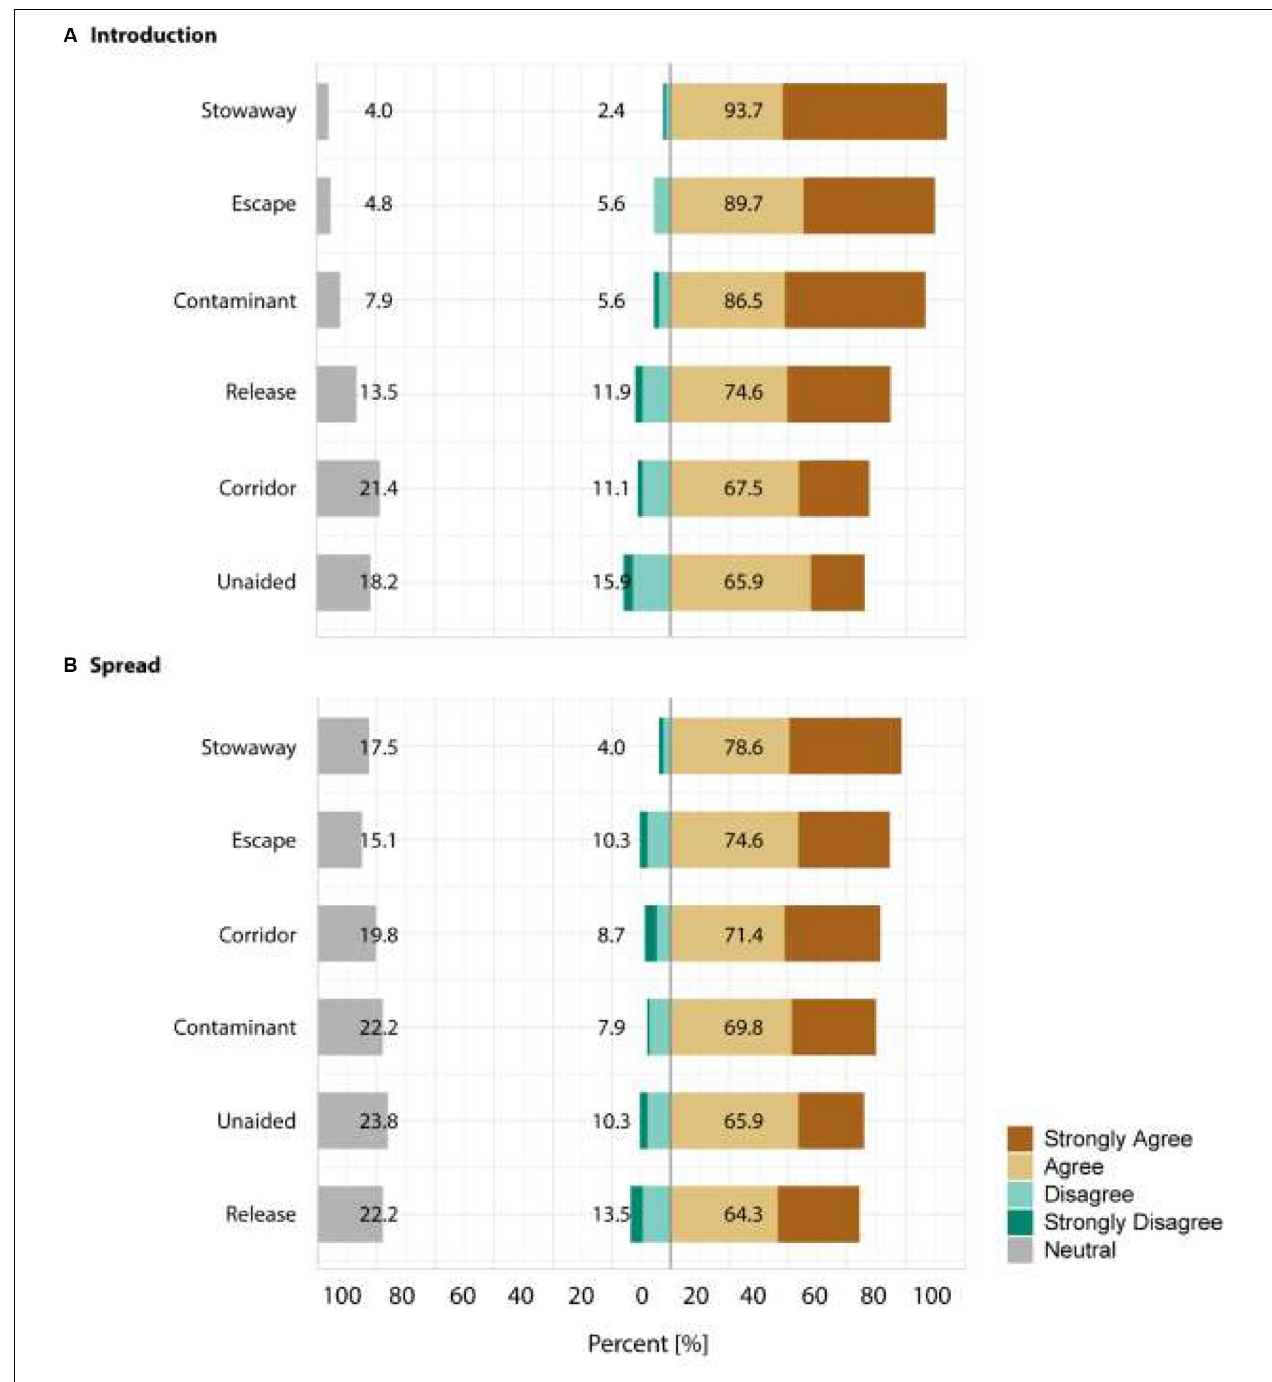
FIGURE 3 | Summary of the answers provided by the 126 respondents for the second section of the survey. Respondents were asked which pathway will significantly increase alien species (A) introductions and (B) spread to/on islands in the 21st century. Answers were provided on a 5-point Likert scale with the categories: strongly disagree, disagree, neutral, agree, and strongly agree. Shown is the percentage of agreement with each of the categories. Values are given for the percent of answers in the neutral category and for the disagreement and agreement categories grouping the respective two answer